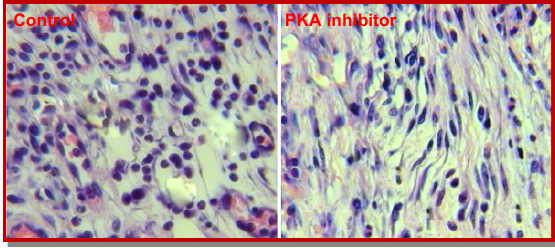
Figure 1: Effects of the PKA inhibitor on skin wound granula- tion tissue in C57BL/6 mice on day 5 after wound creation (hematoxylin and eosin staining; magnification x400)